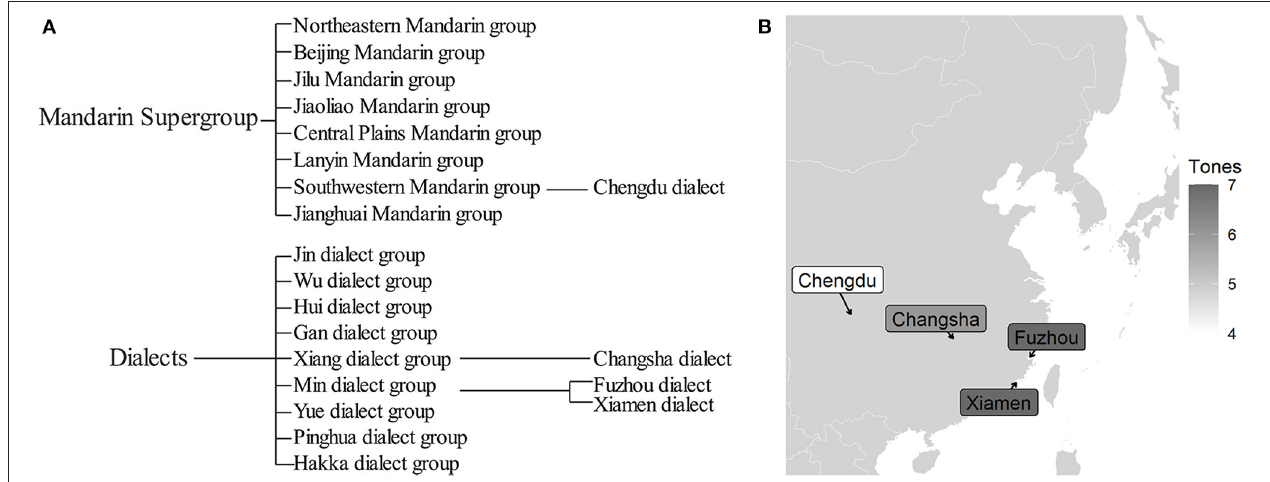
FIGURE 1 | The classification (A) and geographic distribution (B) of four Chinese dialects in this study.